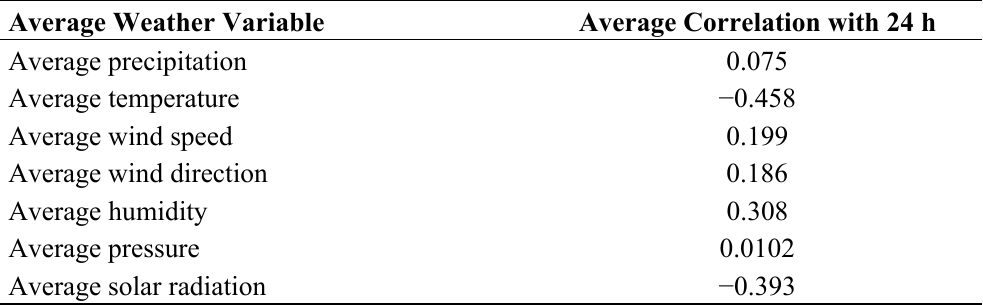
Table 1. Correlation between weather variables and electric power